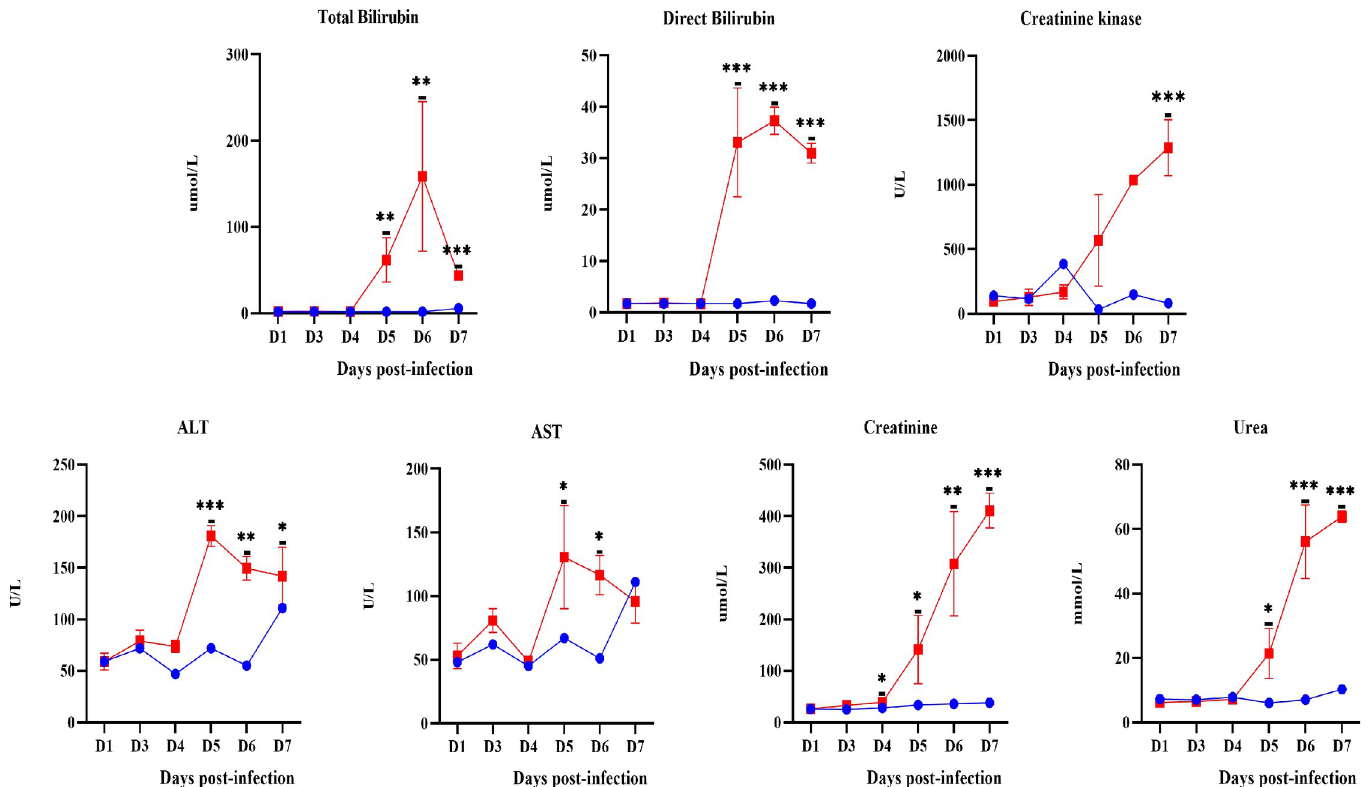
Fig 8. Serum level of total bilirubin, direct bilirubin, CK, ALT, AST, creatinine and urea in control (blue line) and infected hamsters (red lines). The biochemical measurements convey the function state of the liver and kidney. D1-D7: Day 1 to Day 7. � P � 0.05, �� P � 0.01, ��� P � 0.001.